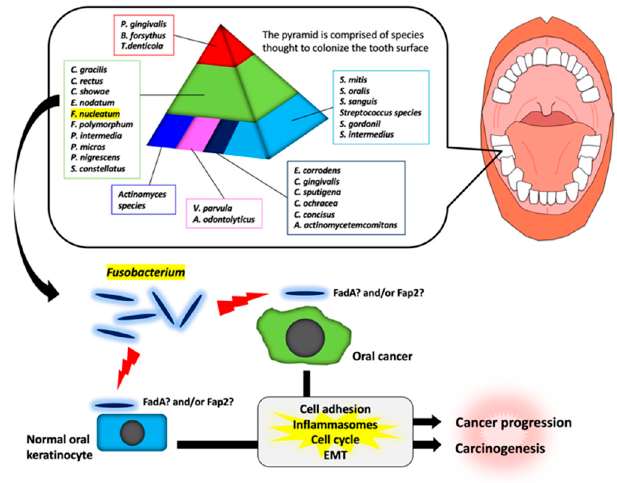
Figure 1. Schematic model for the involvement of Fusobacterium species in oral carcinogenesis and cancer progression. In a dental plaque, various bacteria exist as shown in the pyramid. The base of the pyramid is comprised of species thought to colonize the tooth surface and proliferate at an early stage. Then, complex species in the middle of pyramid becomes numerically more dominant later and is thought to bridge the early colonizers. Finally, the complex species in the top of the pyramid numerically more dominant at late stages in plaque development. Among them, Fusobacterium species may adhere with oral keratinocyte or oral cancer cells via interaction between FadA / Fap2 and E-cadherin. This interaction may induce carcinogenesis and cancer progression.